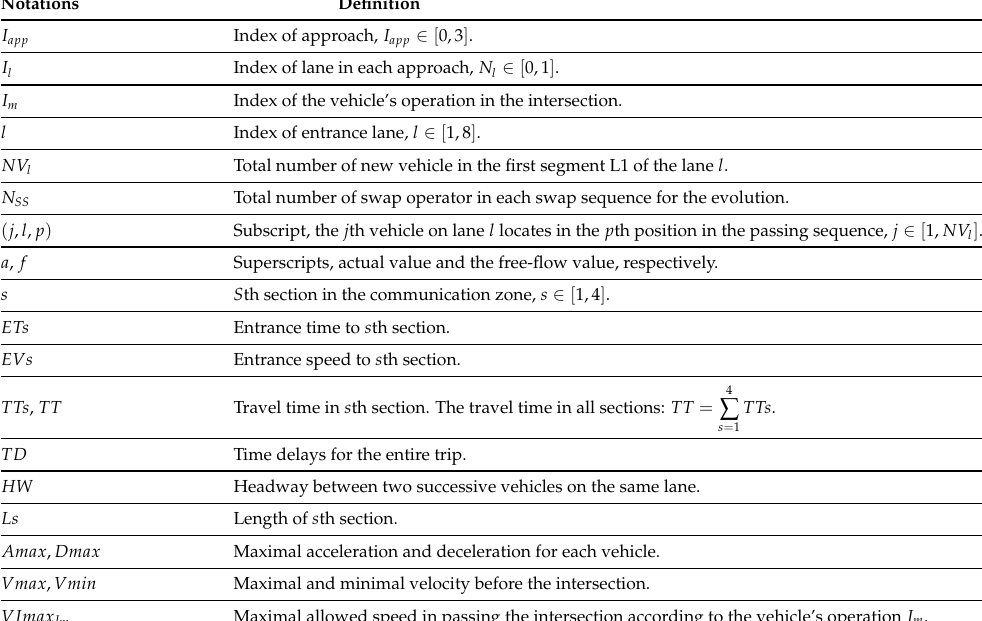
Table 1. Notations